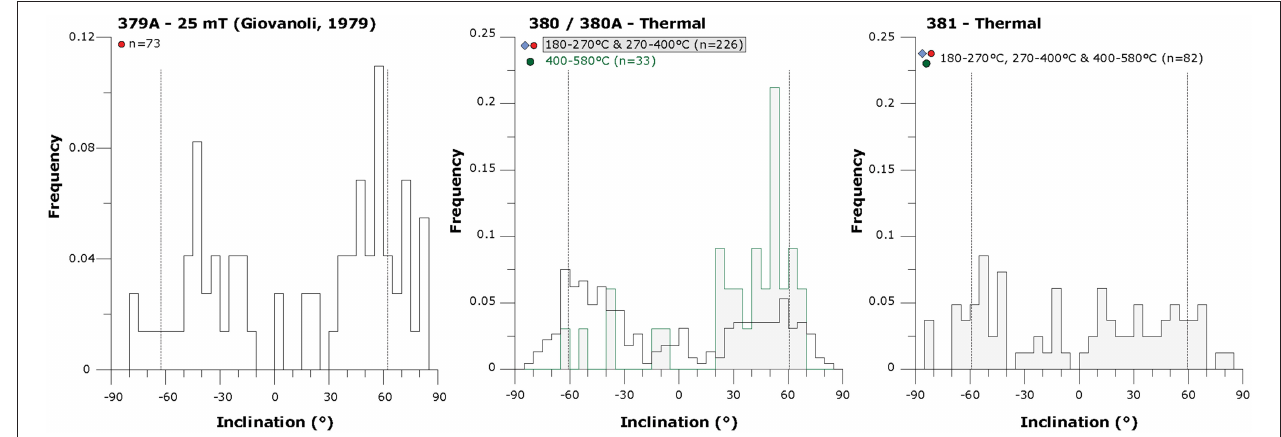
FIGURE 4 | Histograms of inclinations per site, representing the inclination after alternating field demagnetization at 25 mT (Hole 379A) and the best-fit lines of the interpreted temperature components (Hole 380/380A and 381). Vertical bars represent the GAD direction (and inverse) for the sites at time of drilling.